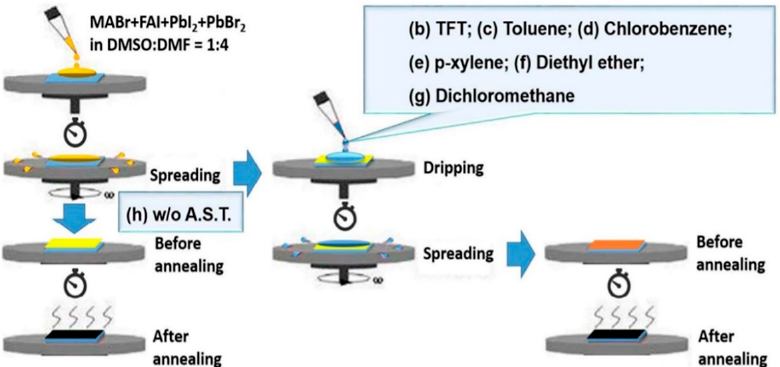
Figure 20. Schematic processing scheme for perovskite films with and without anti-solvent treat- ment [168]. Copyright 2017 American Chemical Society.